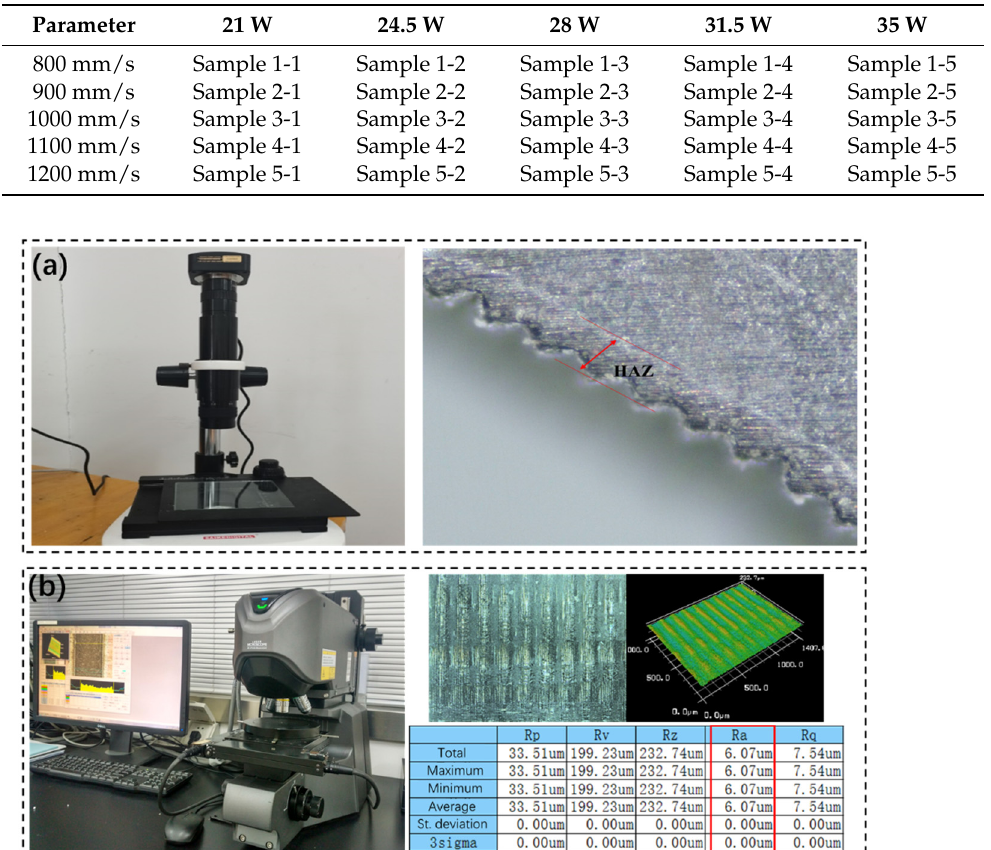
Table 2. Experimental design of CFRP laser cutting.